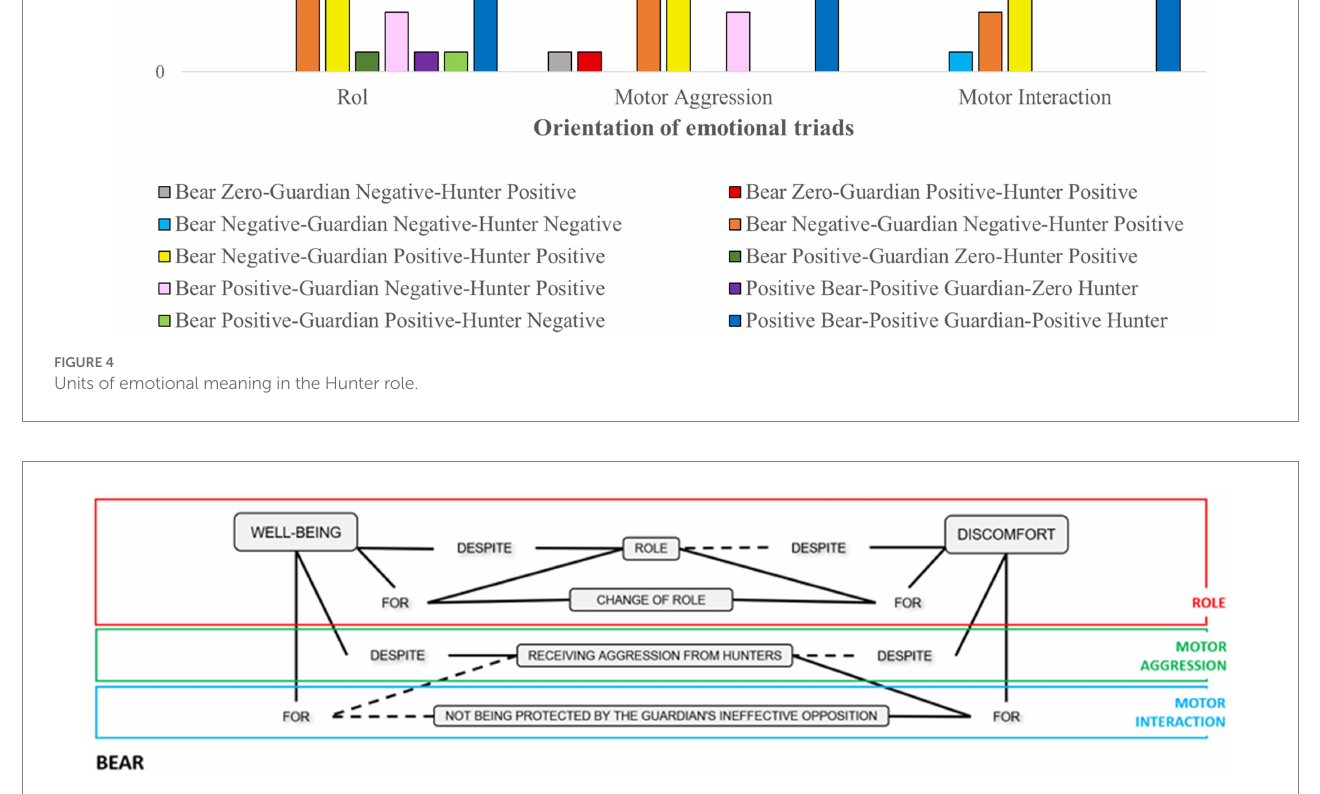
FIGURE 5 Itinerary of the emotional meanings in the three roles. The thickness of the lines corresponds to the frequency of comments. The thicker the lines, the more comments there